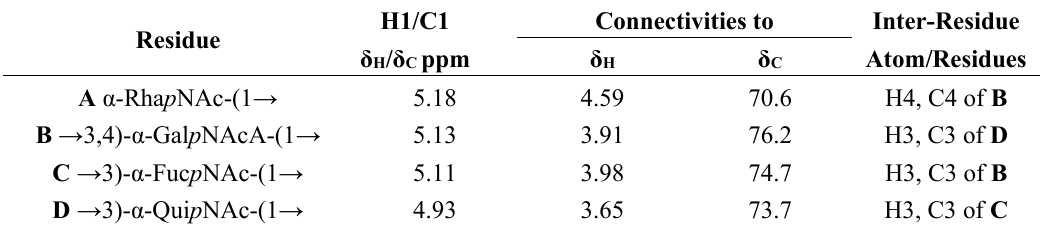
Table 2. Selected inter-residue NOE and 3 J H,C -connectivities from the anomeric atoms of the PS of P. shigelloides O24